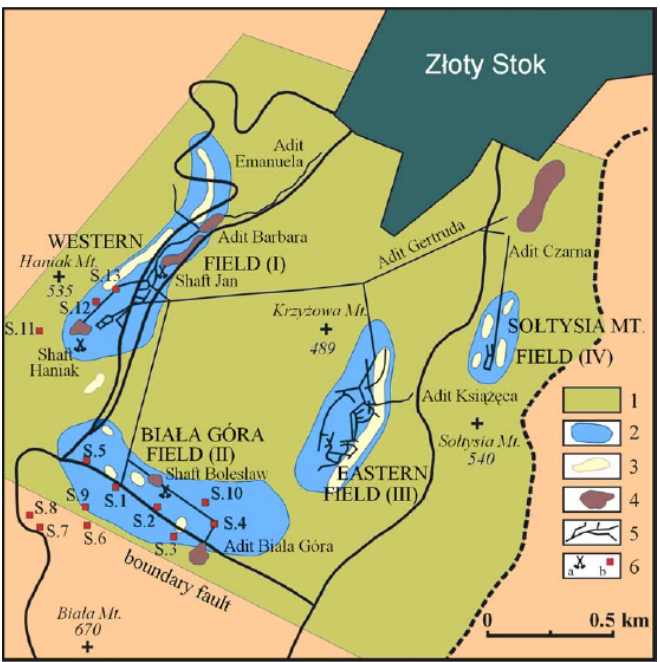
Figure 6. The map of Złoty Stok ore mining area (from in [38]). Legend: 1—mining area,